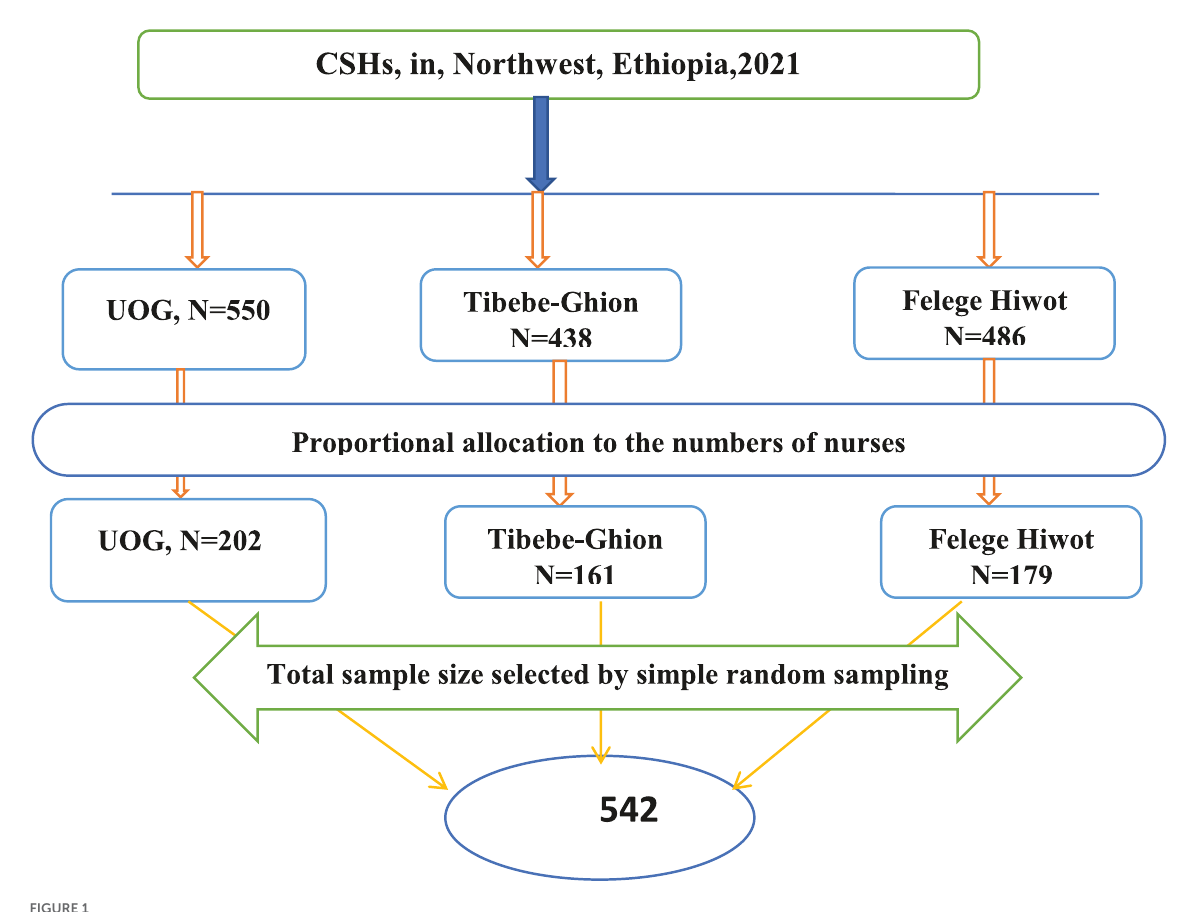
FIGURE1 Proportional allocation of sample size among nurses working at comprehensive specialized hospitals in Northwest, Ethiopia, 2021 ( n =